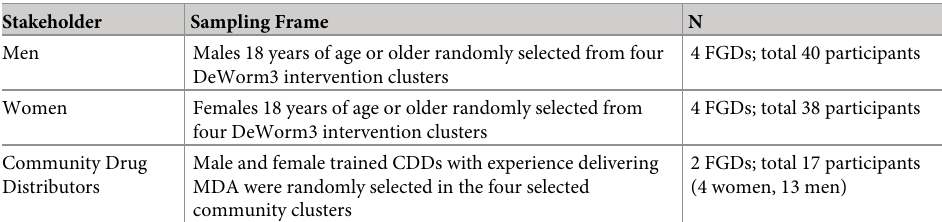
Table 1. Overview of FGDs